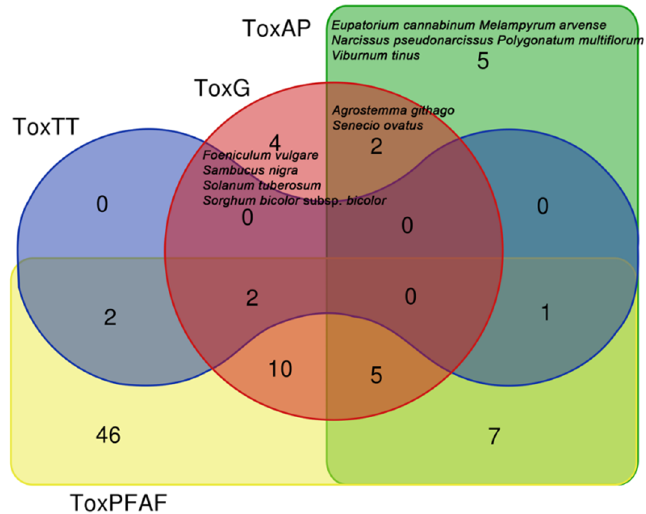
Figure 7. Venn diagram of the toxicity of 198 certain species considered toxic/harmful by Giovanni Targioni Tozzetti (ToxTT) [6], Acta Plantarum (ToxAP) [18], Guarrera (ToxG) [20], and Plants For A Future—PFAF [21] (ToxPFAF).